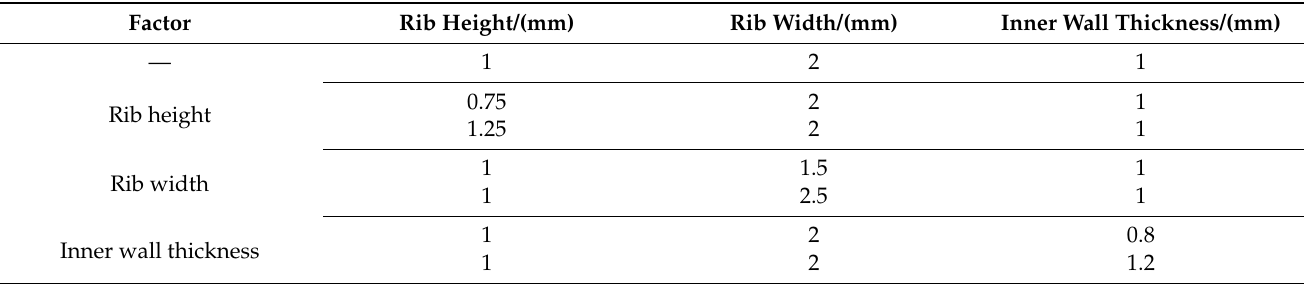
Table 1. Case setting of the variable structure